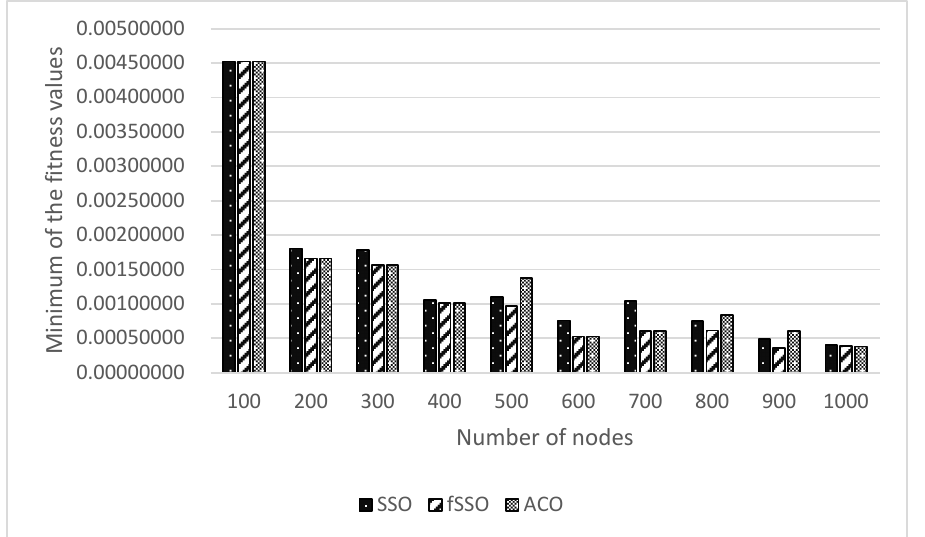
Figure 7. Minimum of the fitness values for ten benchmarks.